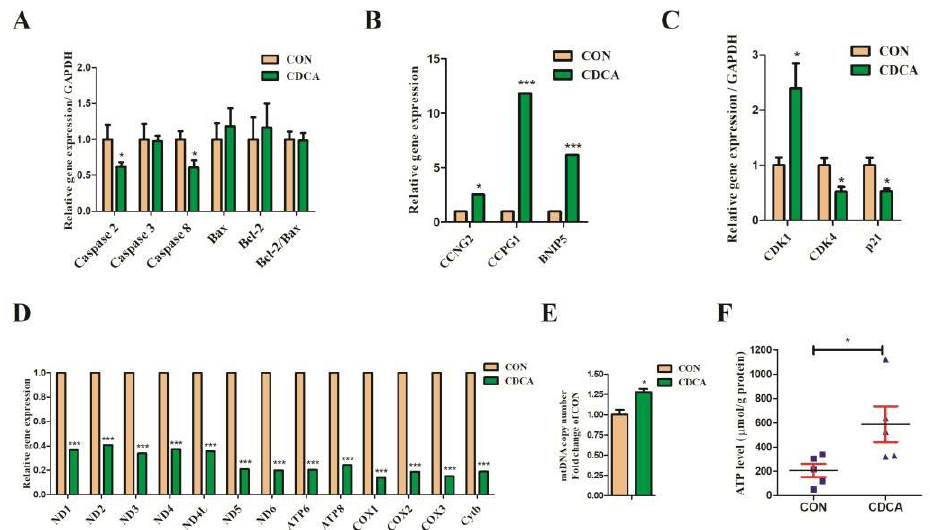
Figure 9. The genes related to cell apoptosis, cell cycle, and mitochondrial content expression are regulated by CDCA treatment. Relative expression of genes related to cell apoptosis ( A ). Relative expression of genes related to cell cycle ( B , C ). Relative expression of mtDNA-encoded gene, NADH dehydrogenase subunits (ND1, ND2, ND3, ND4, etc.), cytochrome b (Cytb), cytochrome c oxidase subunits (COX1, COX2, and COX3), and ATP synthase F0 subunits (ATP6 and ATP8) by RNA-seq ( D ). The copy number of mtDNA ( E ). The level of cellular ATP regulated by CDCA treatment in IPEC-J2 cells ( F ). * p < 0.05, *** p < 0.001 compared with the CON group. Bax, BCL2-associated X; CCNG2, cyclin G2; CCPG1, cell-cycle progression gene 1; Bcl-2, B-cell lymphoma-2; BNIP5, Bcl-2 interacting protein 5; CDK, Cyclin-dependent kinase; ND, NADH dehydrogenase subunit; COX, cytochrome c oxidase subunit; Cytb, cytochrome b; ATP, ATP synthase F0 subunit.